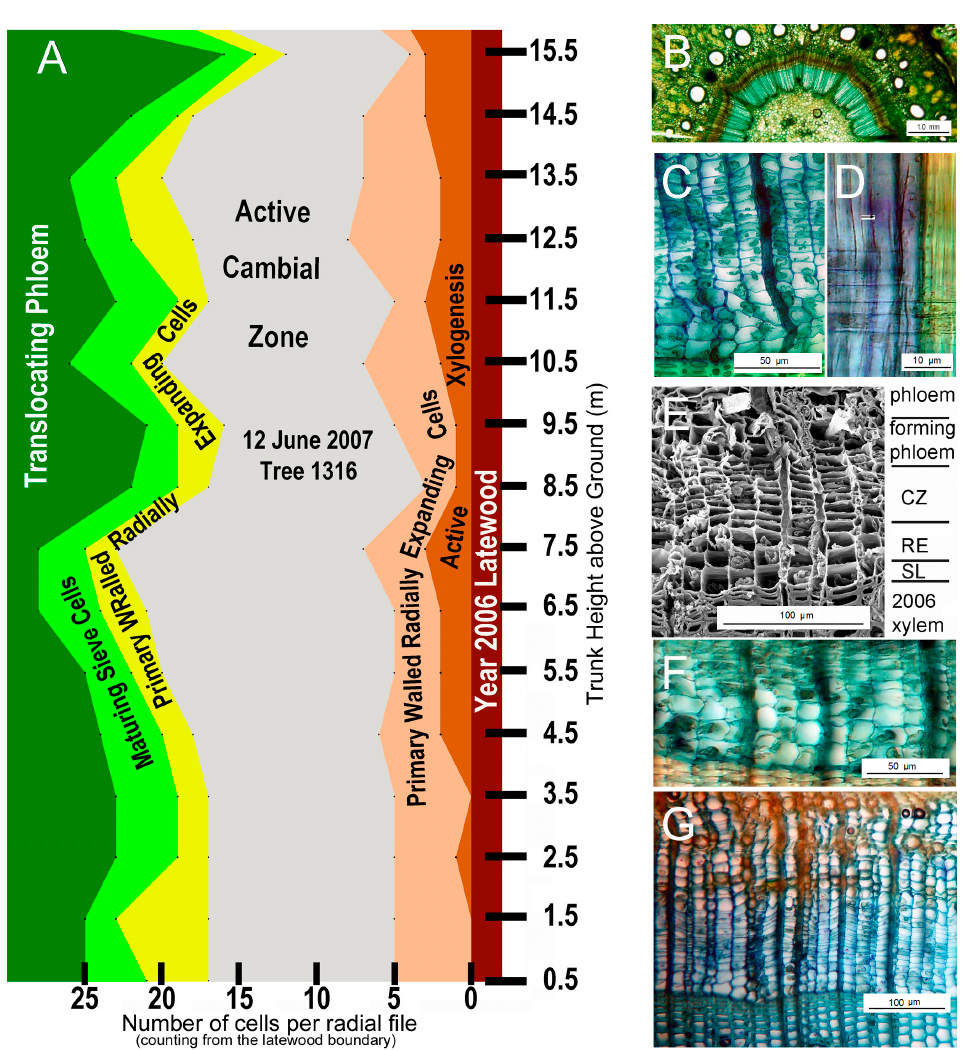
Figure 19. The anatomical state of the cambial region at several heights above ground on the south side of the trunk in tree 1316 on 12 June 2007. ( A ) A graphical overview of the trunk from near ground level to tree top. ( B ) Transverse section showing the state in a treetop twig: the cambial zone (brown) is surrounded on its outside (centrifugally) by a relatively wide zone of new phloem cells and centripetally by a band comprising several enlarged cells per radial file becoming new earlywood tracheids through secondary-wall deposition and lignfication; the 2006 layer of mature secondary xylem (blue) is centripetal to that zone of xylogenesis. ( C ) Transverse section of the CZ and RE zones at 12.5 m trunk height. ( D ) Radial section at 12.5 m trunk height; a developing bordered pit is arrowed. ( E ) Scanning electron microscope image of the cambial region at 9.5 m height showing zones of developing phloem, cambial growth (CZ), xylogenesis (SL) and gišogenesis (RE + SL). ( F ) Transverse section of part of the CZ and all of the RE zones at 3.5 m trunk height. ( G ) Transverse section at 0.5 m trunk height showing active phloegenesis, cambial growth and early gišogenesis not yet attended by